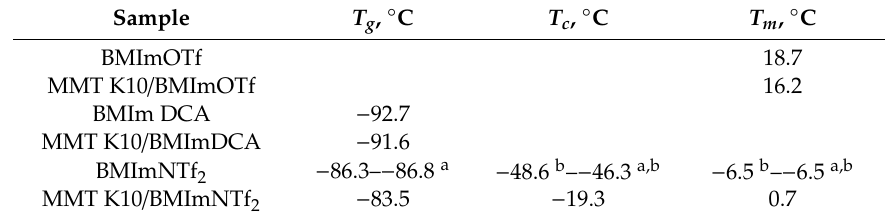
Table 2. Characteristic temperatures of thermal behaviour of the samples under study, determined by